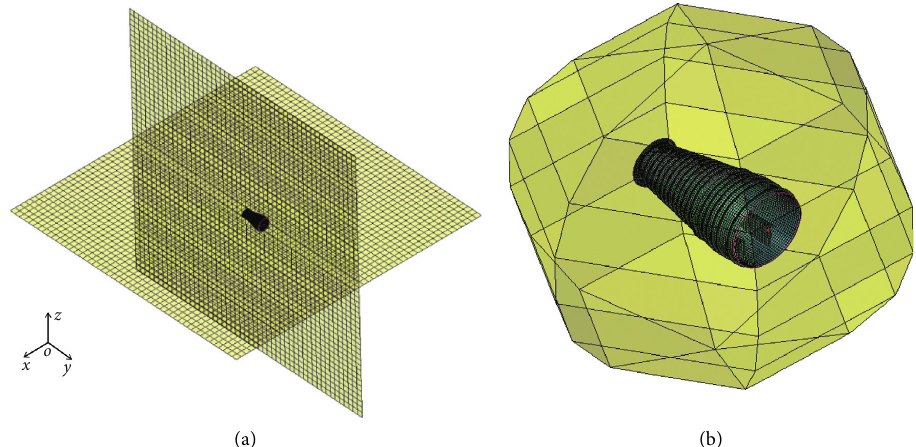
Figure 4: Models of acoustic field and structure. (a) Planar acoustic field model. (b) ISO acoustic field model.